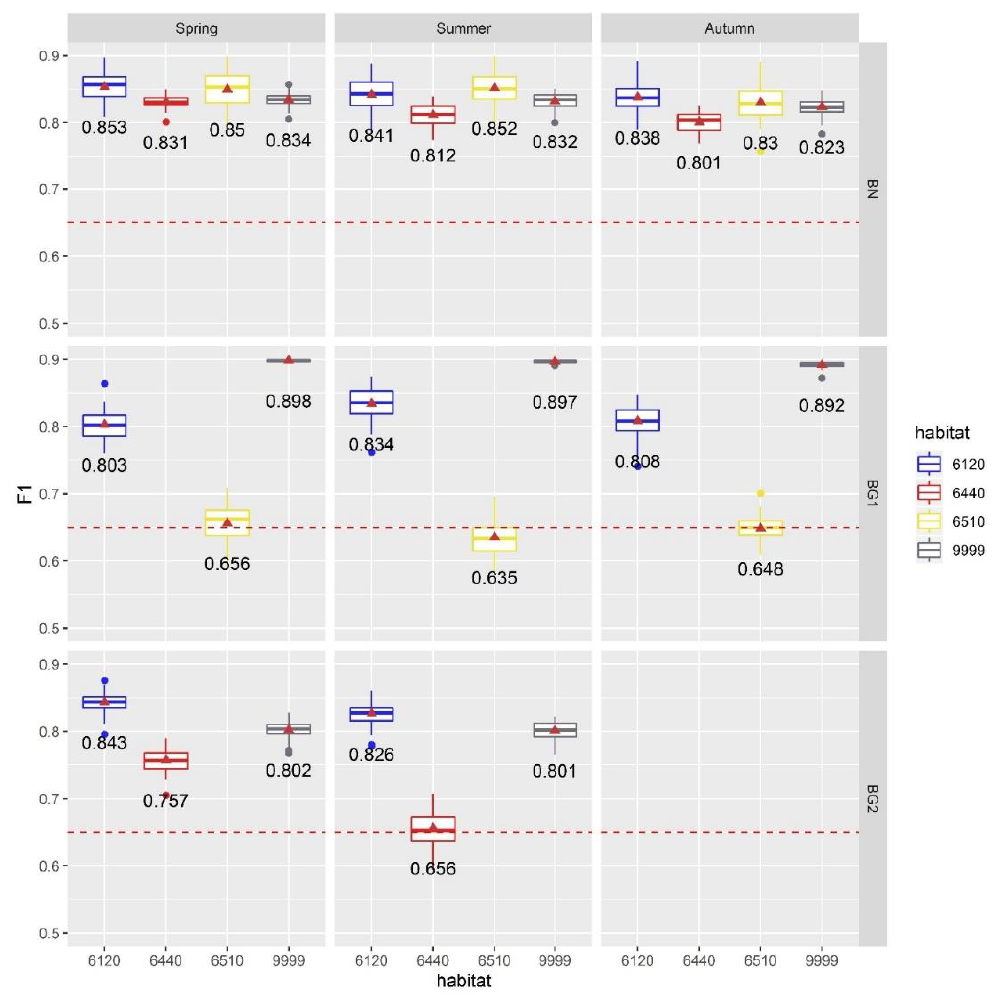
Figure 13. F1 accuracies of the 4 classified habitats (Exp. 3b). Red triangles represent the mean F1 values (also written). Boxplots show the median, the lower, and upper hinges corresponding to the first and third quartiles; the upper and the lower whiskers are the 1.5 · interquartile range. Red dotted lines represent a confidence level of K = 0.65.